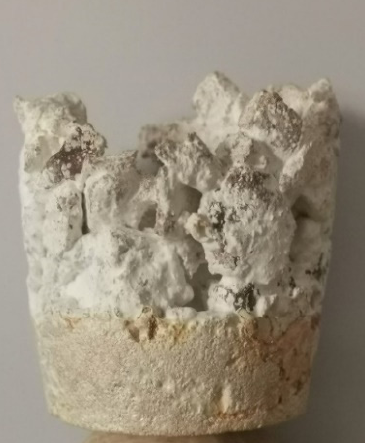
Figure 10. Mycelium-based composite: smooth and rough textures, combined in one object (design